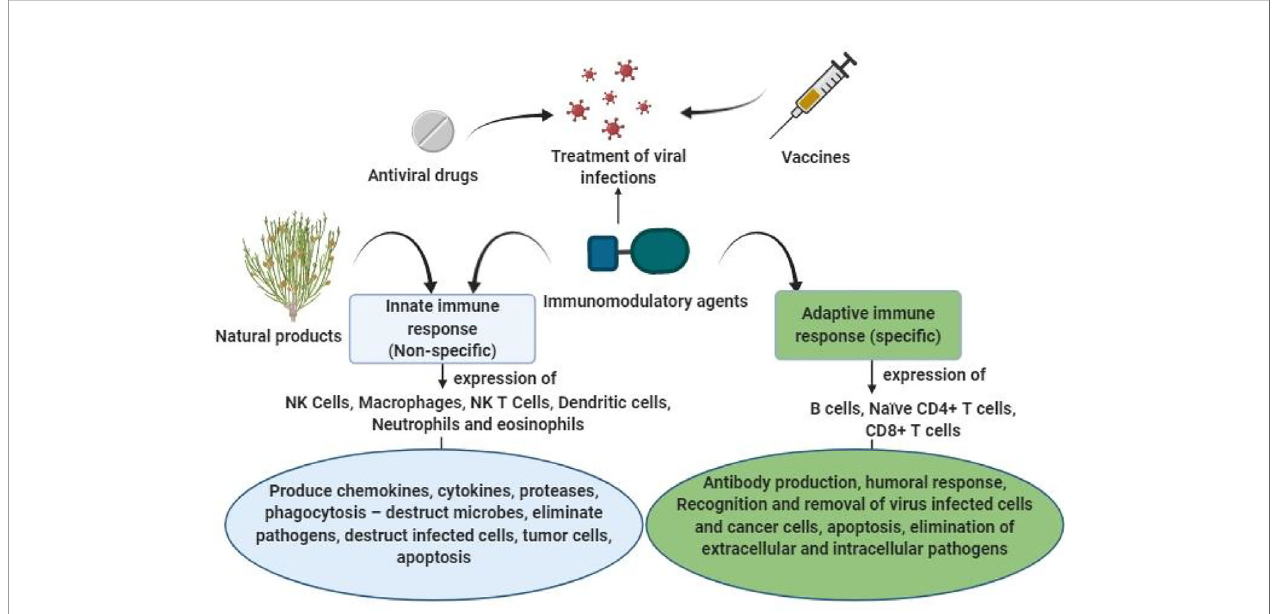
FIGURE 1 | Possible role of natural immunomodulators for prevention and treatment of viral